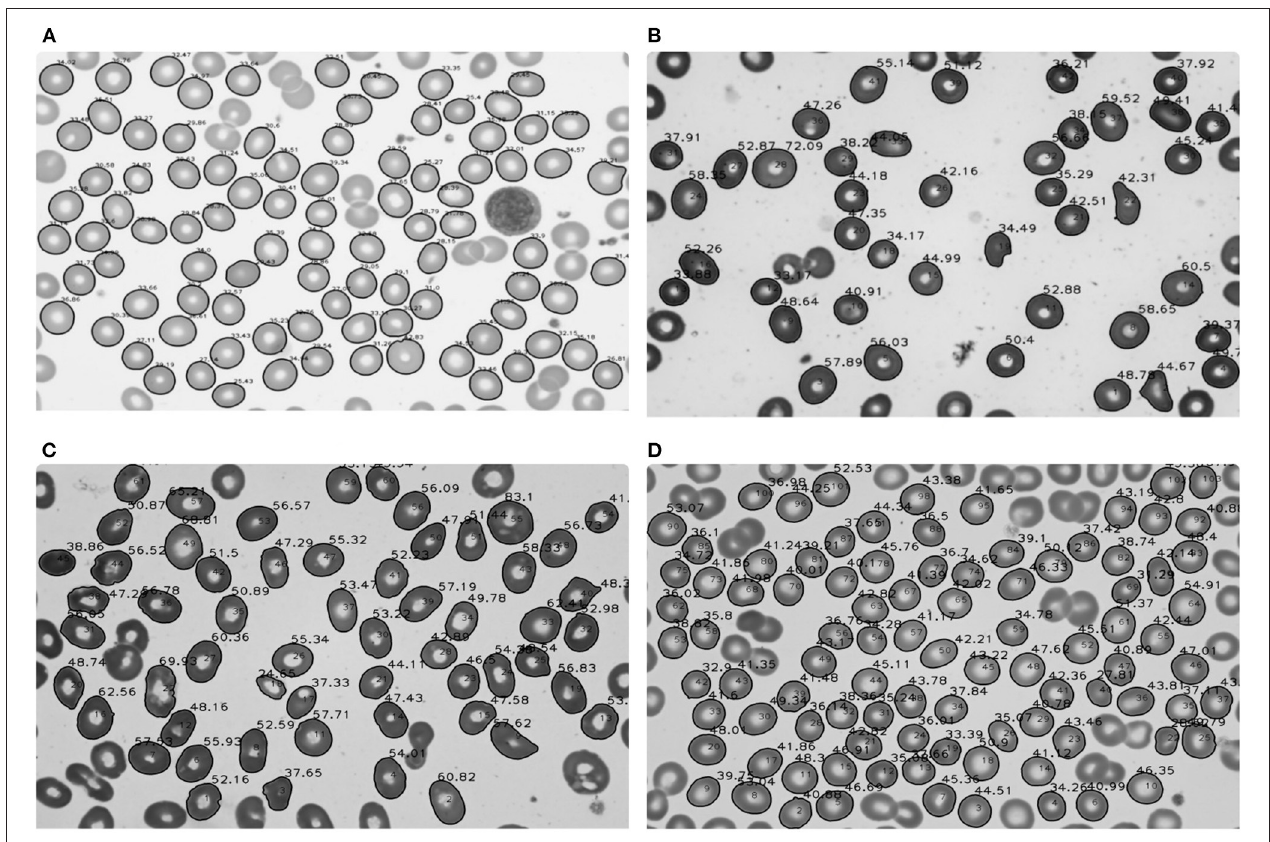
FIGURE 2 | Area calculation results of red blood cells in normal subjects and patients with aplastic anemia (AA), megaloblastic anemia (MA), and myelodysplastic syndrome (MDS). (A) Area calculation results in one normal subject; (B) Area calculation results in one patient with AA; (C) Area calculation results in one patient with MA; (D) Area calculation results in one patient with